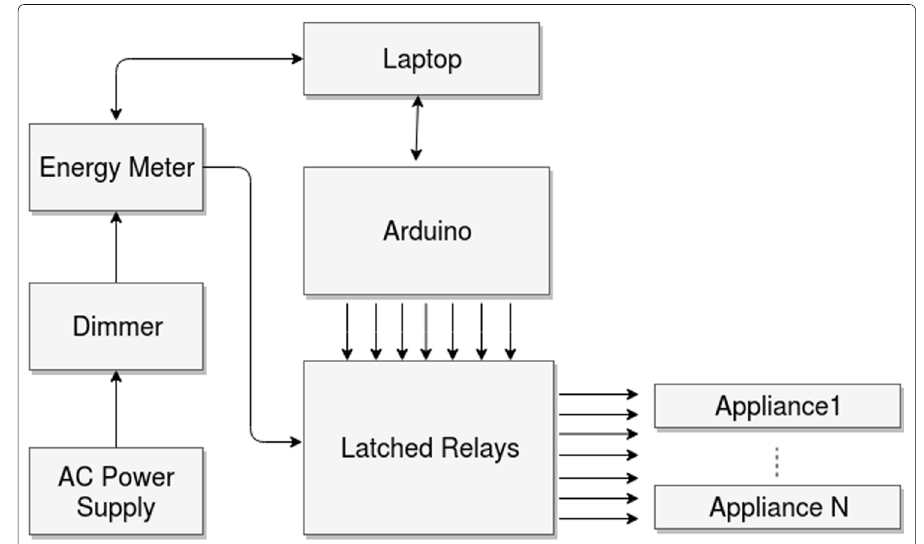
Fig. 2 Block diagram of NILM data collection